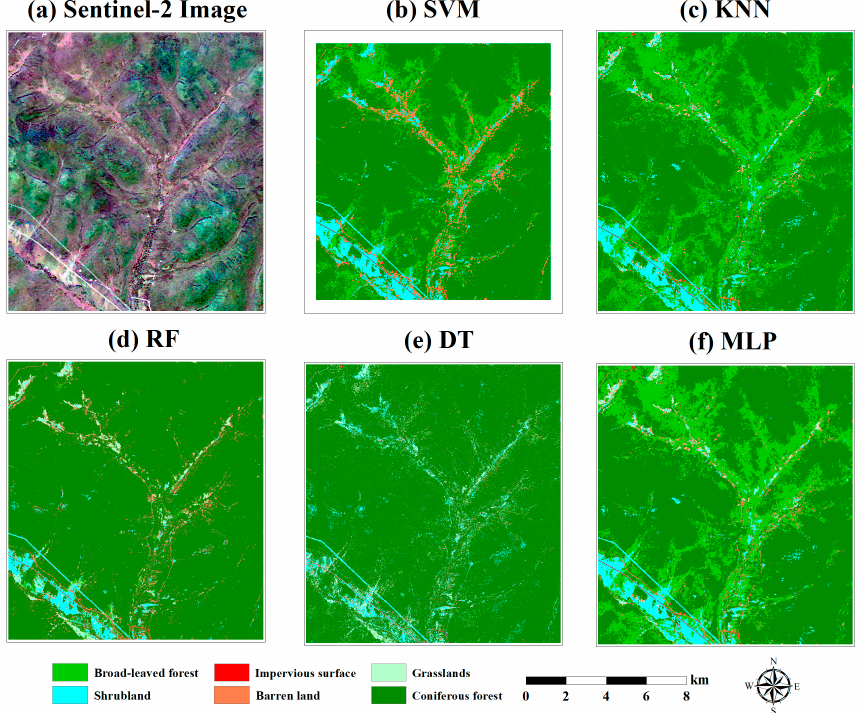
Figure 4. Sentinel-2 remote sensing image ( a ) and forest land resource information maps of the five- classifiers based on Mul-vegetation features: ( b ) SVM classifier; ( c ) KNN classifier; ( d ) RF classifier; ( e ) DT classifier; ( f ) and MLP